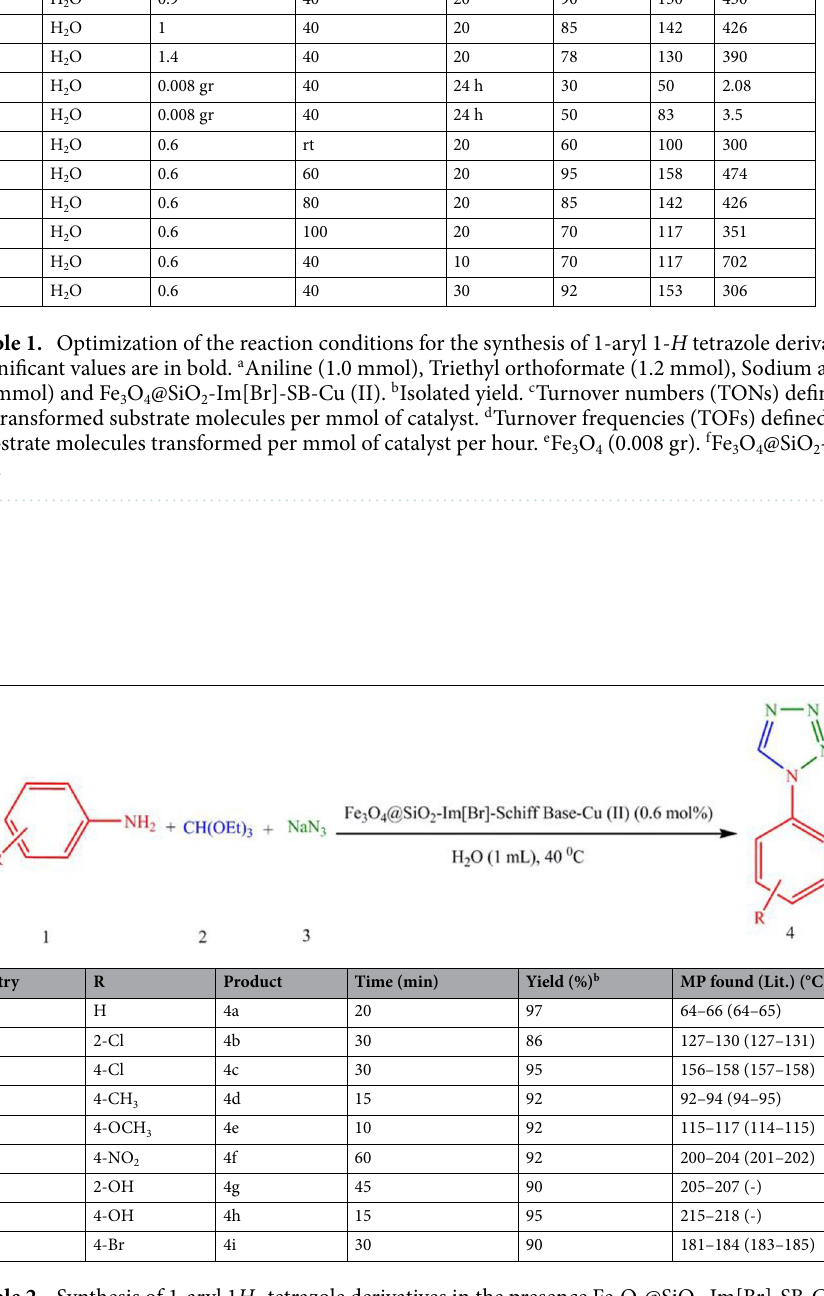
Table 2. Synthesis of 1-aryl 1 H - tetrazole derivatives in the presence Fe 3 O 4 @SiO 2 -Im[Br]-SB-Cu (II) catalyst a . a Reaction conditions: Aniline (1.0 mmol), Triethyl orthoformate (1.2 mmol), Sodium azide (1.0 mmol)